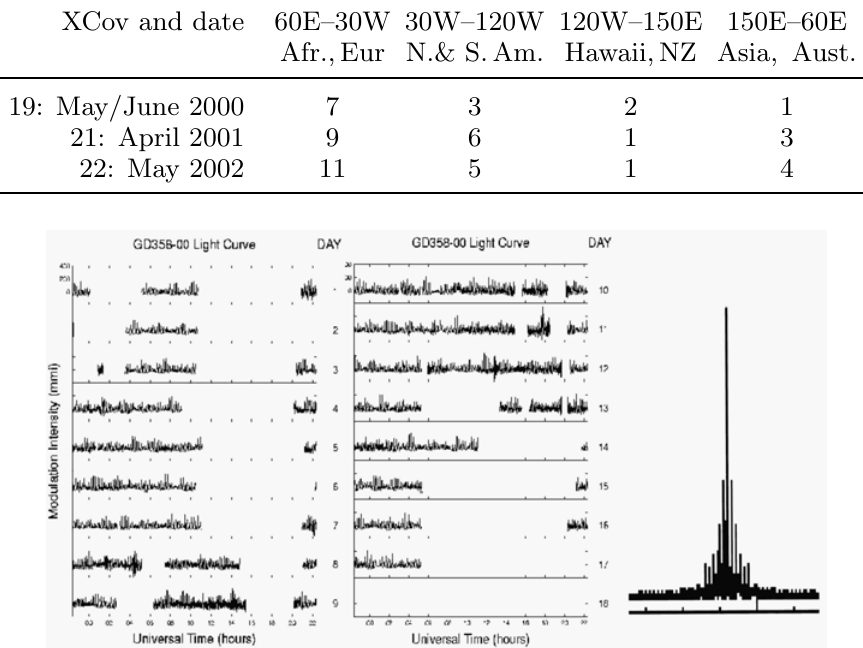
Fig. 3. This is the usual way for presenting in the internet the results from an ongoing WET campaign. In this example, XCov19 in May/June 2000 is shown. The left and center panels show the light curve from the first and second week of the campaign, and the rightmost panel is the resulting window function, in milliamplitude